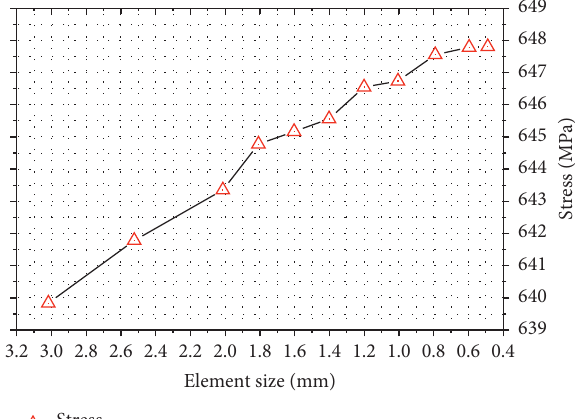
Figure 12: Relationship between mesh size and shear strength.